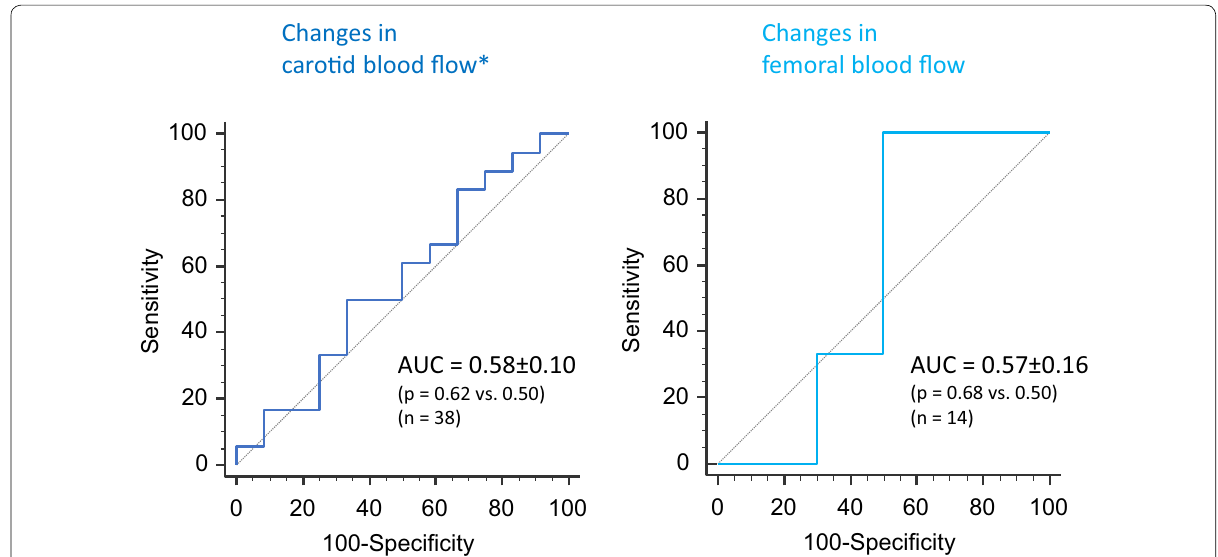
Fig. 3 Receiver operating characteristic curves describing the ability of changes in carotid femoral blood flows to detect a positive response of cardiac index to a passive leg raising test (increase 10%). AUC area under the curve. Asterisks results are provided for carotid blood flow measured ≥ by the velocity time integral